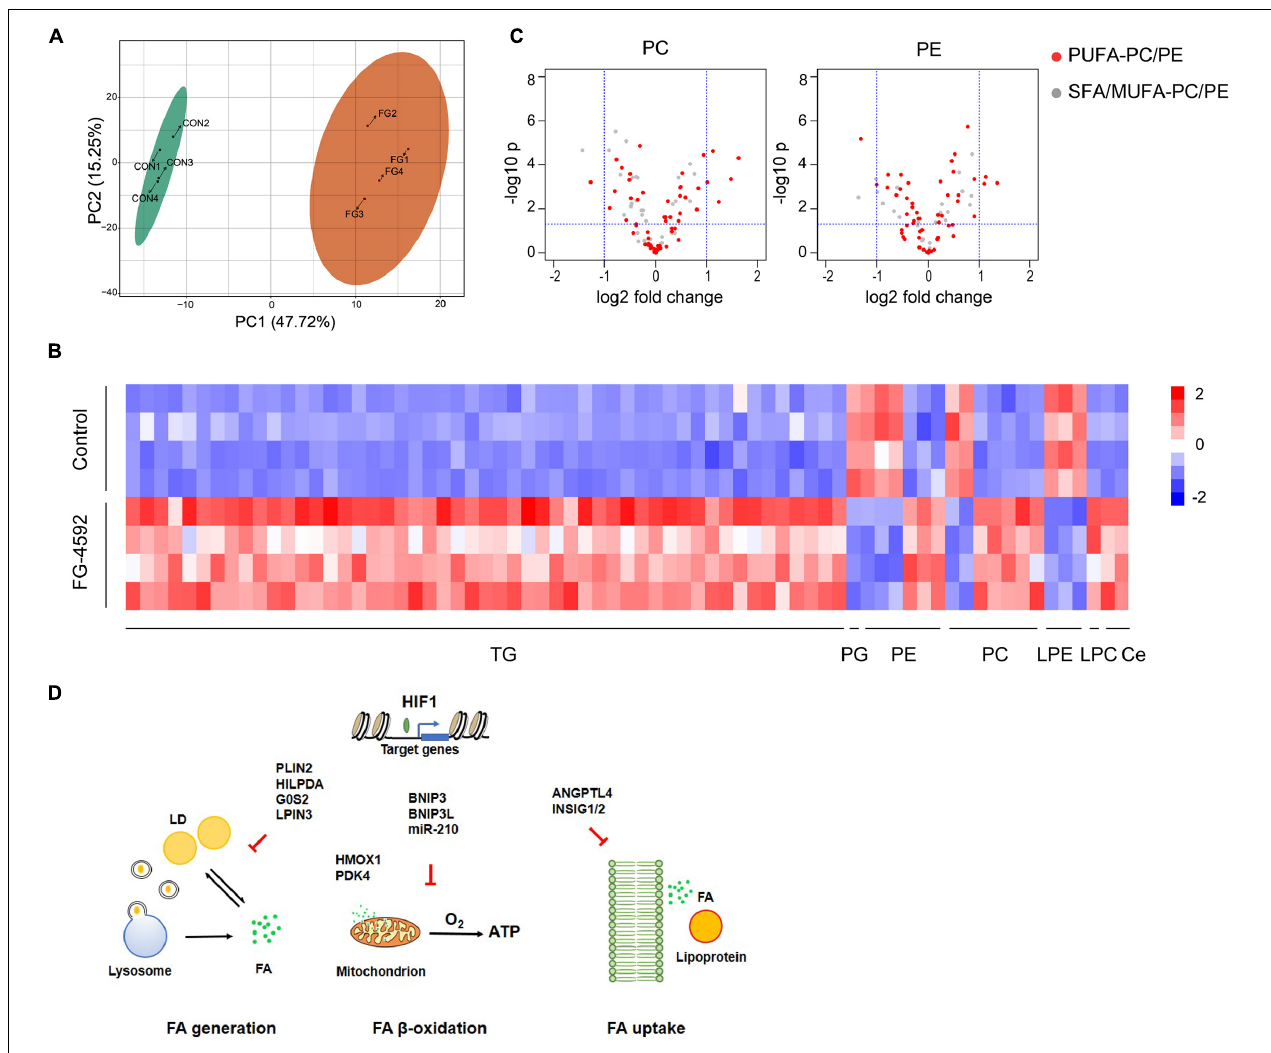
FIGURE 6 | HIF1 α -induced lipidomics alterations in kidney tubular cells. (A) PCA score plots based on the identified lipid metabolites by LC-MS/MS of HK2 cells treated or untreated with 50 µ M FG-4592. CON: Control group. FG: FG-4592 treated group. N = 4. (B) Heatmap of the differentially enriched lipid species. | log 2 fold change| > 1, VIP ≥ 1. TG, triglyceride; PG, phosphatidylglycerol. PE, phosphatidylethanolamine; PC, phosphatidylcholine; LPE, lysophosphatidylethanolamine; LPC, lysophosphatidylcholine; Ce, ceramide. (C) Volcano plots showing the changes in PC/PEs grouped as PUFA-PCs/PEs (red fill) and